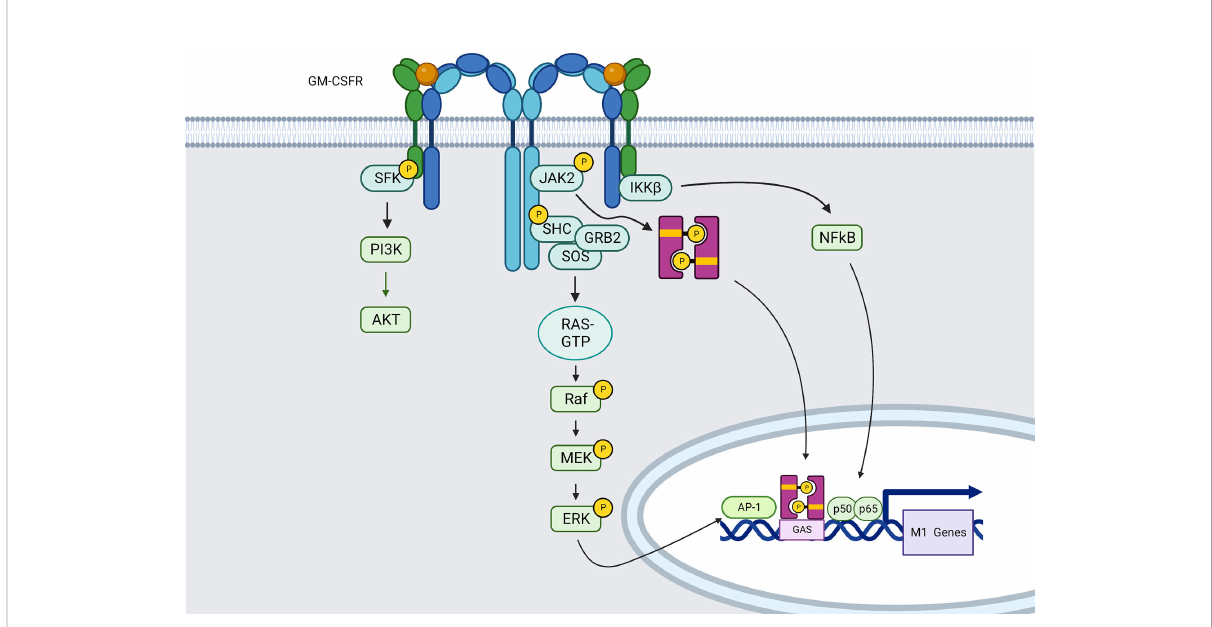
FIGURE 3 GM-CSFR induced signaling pathways in macrophages (created using BioRender ®